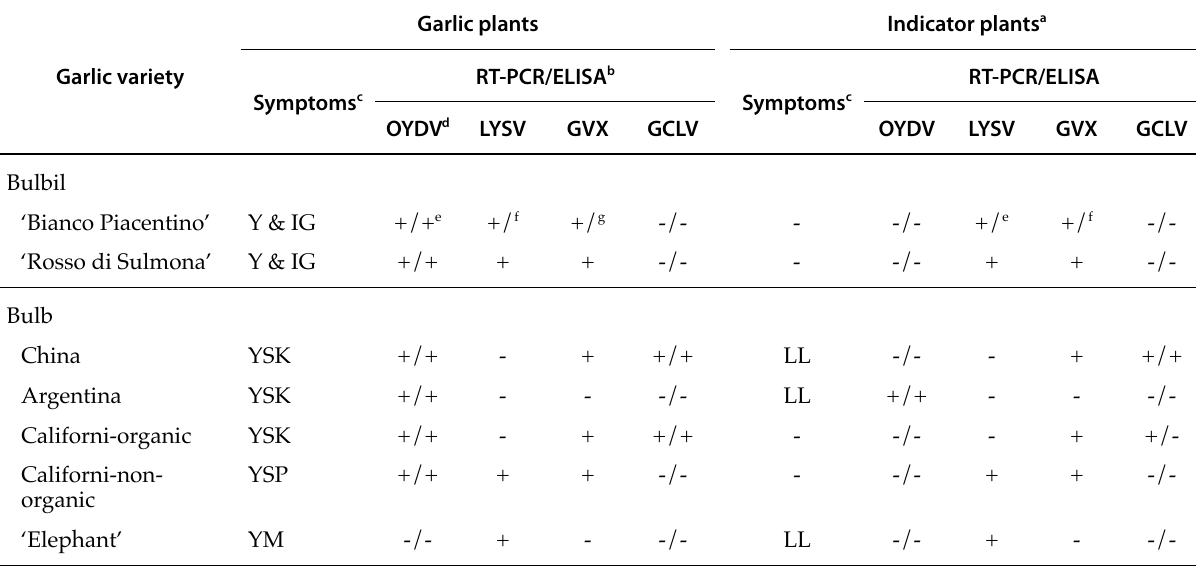
Table 2. Symptom observations and results of biological and laboratory tests for the detection of allium viruses in garlic plants propagated from different types of reproductive